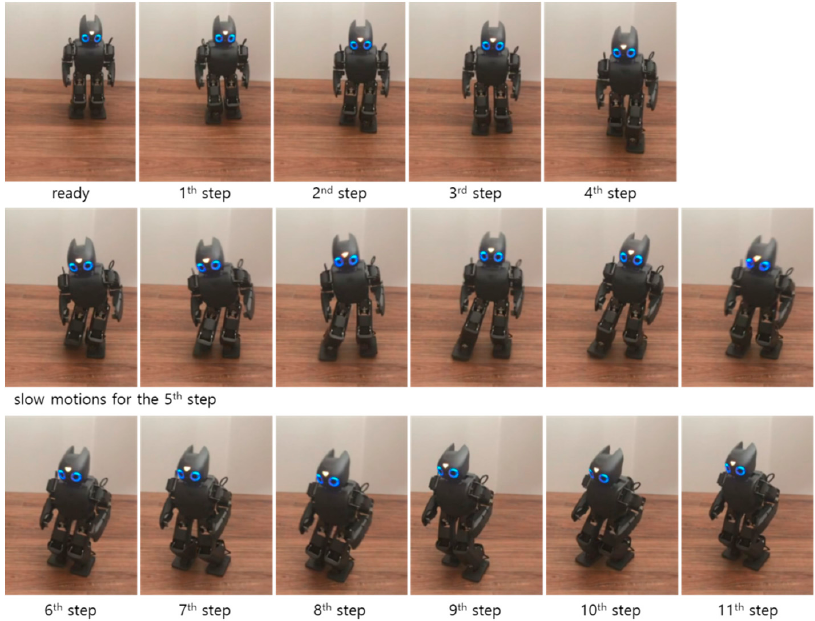
Figure 14. Snapshots of the experiment result without the walking stability controller (left to right, top to bottom).